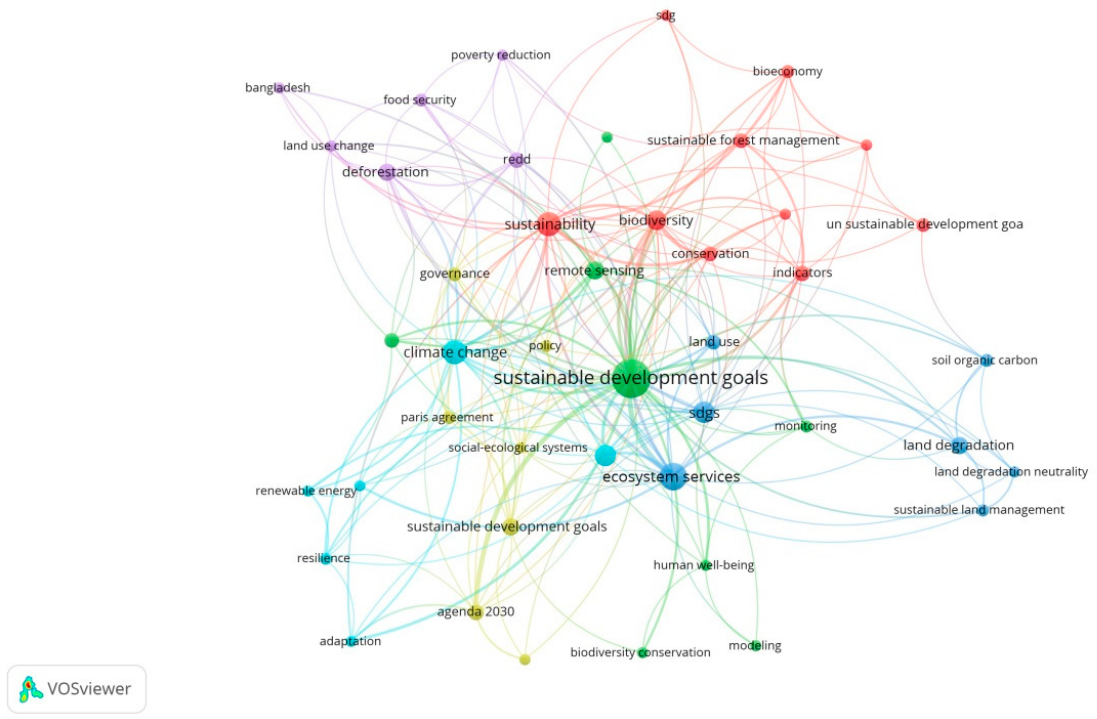
Figure 8. Keyword co-occurrence network. The size of each keyword (node) represents the number of occurrences in the documents analyzed. The colors represent different clusters.